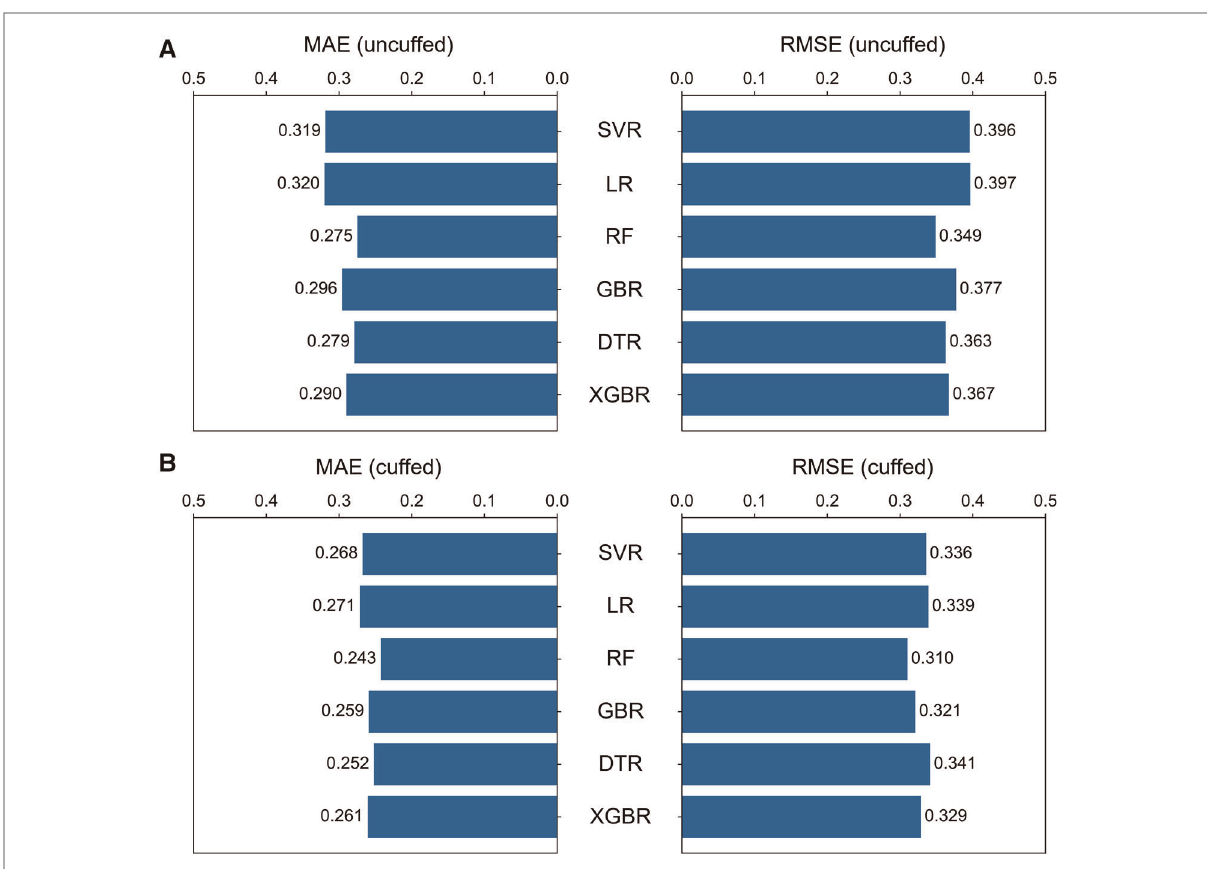
FIGURE 4 Comparison of the six machine learning models. The bar graphs showing the MAE and RMSE for uncuffed ETT ( A ) and the cuffed ETT ( B ) size prediction with six machine learning models. The random forest model performed the best of all models, and among the linear models, the support vector regression model performed better. SVR=support vector regression, LR=linear regression, RF=random forest, GBR=gradient boosting tree, DTR=Decision tree, XGBR=extreme gradient boosting